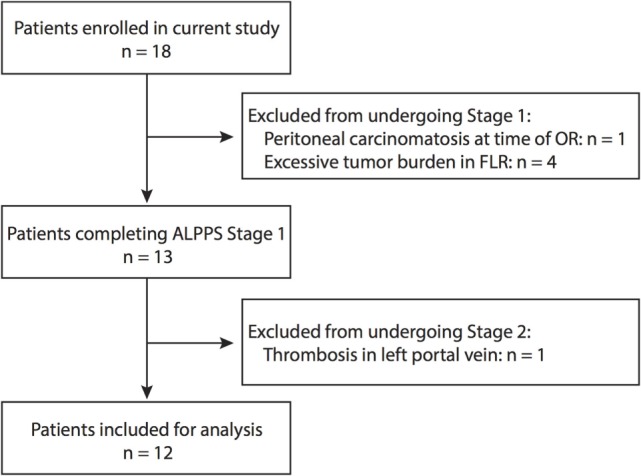
Patient enrollment for this study. The provided flow chart outlines at what stages patients were excluded from the study based on the defined criteria.